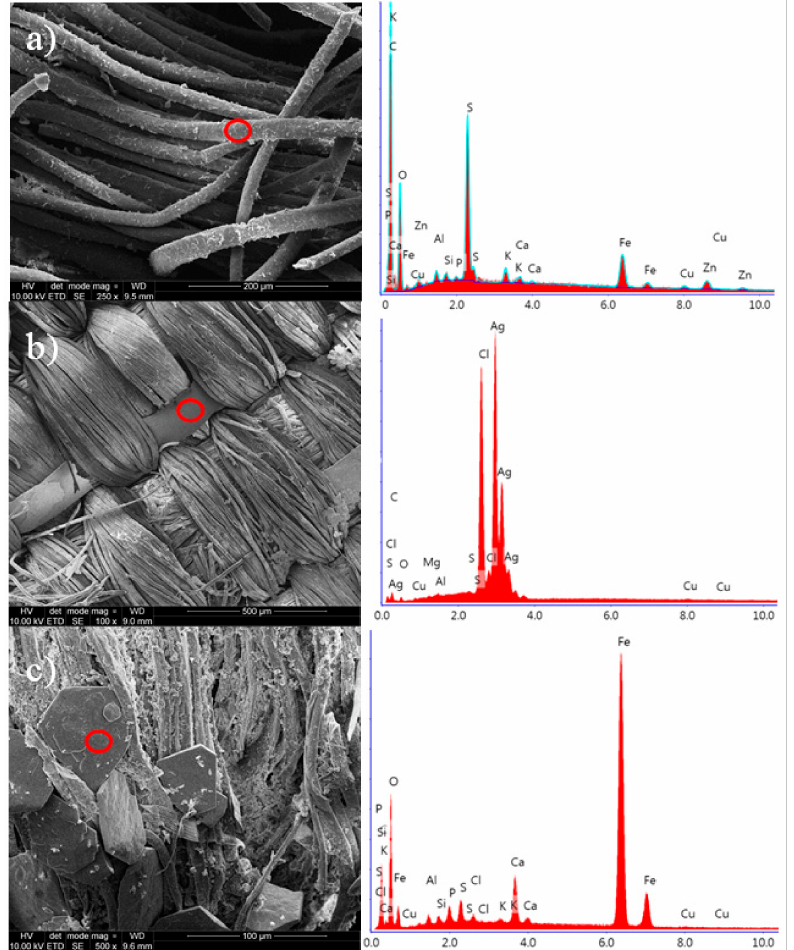
Figure 3. SEM micrographs (on left) and EDS spectra (on right) of: ( a ) woollen threads C8/b7 with high amount of sulphur, ( b ) silk threads C5/b14 with silver strips, and ( c ) silk threads C9/b1-2 containing iron contaminants (magnitude 2500 ×